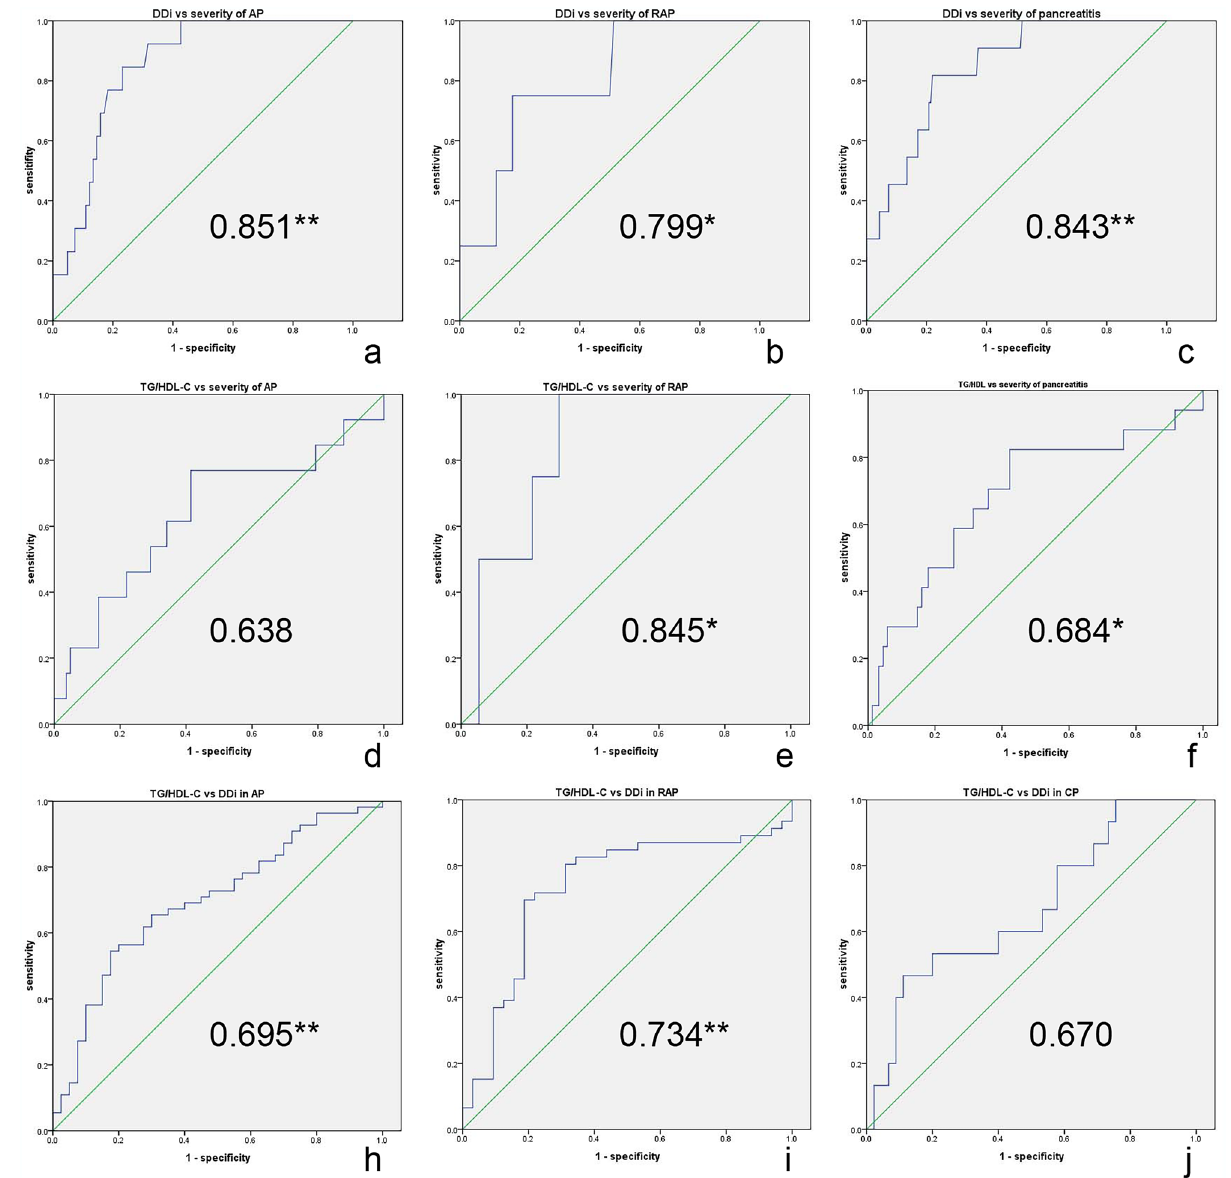
Figure 4. ROC curves of D-dimer and dyslipidemia in different types of pancreatitis. ( a ) ROC curves for D-dimer level to distinguish MAP and non-MAP group in AP. ( b ) ROC curves for D-dimer level to distinguish MAP and non-MAP group in RAP. ( c ) ROC curves for D-dimer level to distinguish MAP and non-MAP group. ( d ) ROC curves for TG/HDL-C level to distinguish MAP and non-MAP group in AP. ( e ) ROC curves for TG/HDL-C level to distinguish MAP and non-MAP group in RAP. ( f ) ROC curves for TG/HDL-C level to distinguish MAP and non-MAP group. ( g ) ROC curves for TG/HDL-C level to distinguish normal D-dimer group and increased D-dimer group in AP. ( h ) ROC curves for TG/HDL-C level to distinguish normal D-dimer group and increased D-dimer group in RAP. ( i ) ROC curves for TG/HDL-C level to distinguish normal D-dimer group and increased D-dimer group in CP. *p < 0.05; **p <